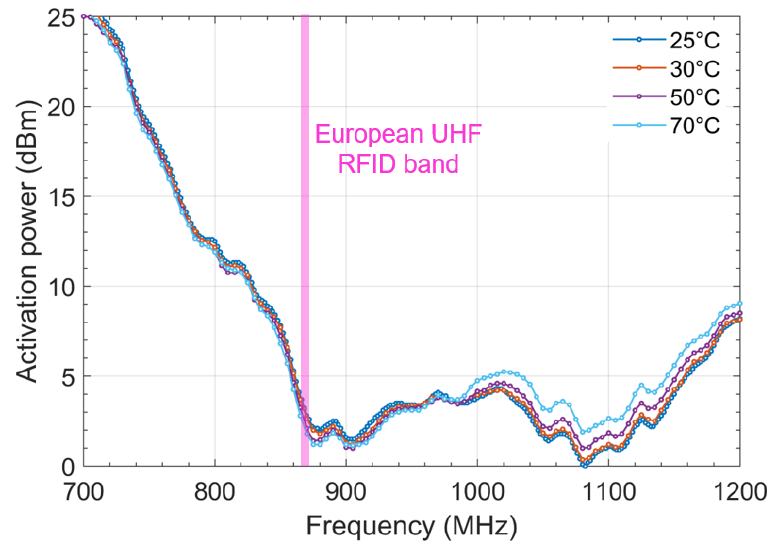
Figure 6. Impact of the temperature on the activation power of the reference tag.